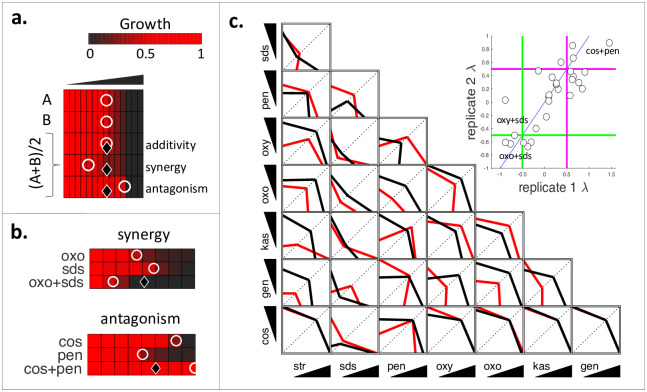
Measurement of all pairwise interactions among eight drugs in E. amylovora using diagonal assays.(a) In these assays, cells are grown in linearly increasing doses of two single drugs (A and B) and an equipotent mixture of these two drugs. Growth is represented by a black (no growth) to red (growth in no drug condition) colorbar. The observed dose that results in 50% growth inhibition (IC50) is indicated by a white circle. The expected IC50 of the combination is indicated by a black triangle. When drugs are mixed, the observed IC50 of the combination may be lower, equal or higher than the expected IC50, corresponding to synergy, additivity or antagonism, respectively. λ score is defined by log2(obs IC50 / exp IC50), hence negative, zero or positive values correspond to synergy, additivity or antagonism, respectively. (b) Examples of observed synergy and antagonism. The observed IC50 of oxo+SDS combination is smaller than the observed IC50s of single compounds and the expectation calculated for the combination, indicating synergy. cos+pen has almost no effect while both single drugs cos and pen have growth inhibition effects, indicating antagonism. The three-letter abbreviations for all drugs were given in Table 1. (c) Summary of diagonal method results for all pairwise interactions. We projected the observed IC50 in single drugs and two-drug combination in each experiment to a 2D matrix and connected these three points to construct an isophenotypic contour. Red and black contours correspond to two replicates. Similar to the checkerboard assay interpretation, concave or convex contours indicate that the drug combination is synergistic or antagonistic, respectively. The inset shows that replicate λ scores strongly correlate (Spearman r = 0.79, P-value = 2.2 x 10−6). Green and magenta lines correspond to synergy (λ < -0.5) and antagonism (λ > 0.5) thresholds.